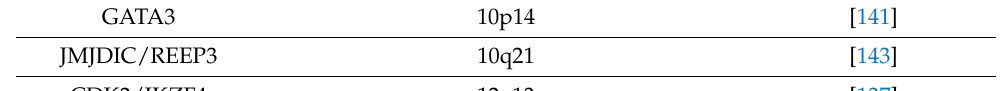
Genome-wide association